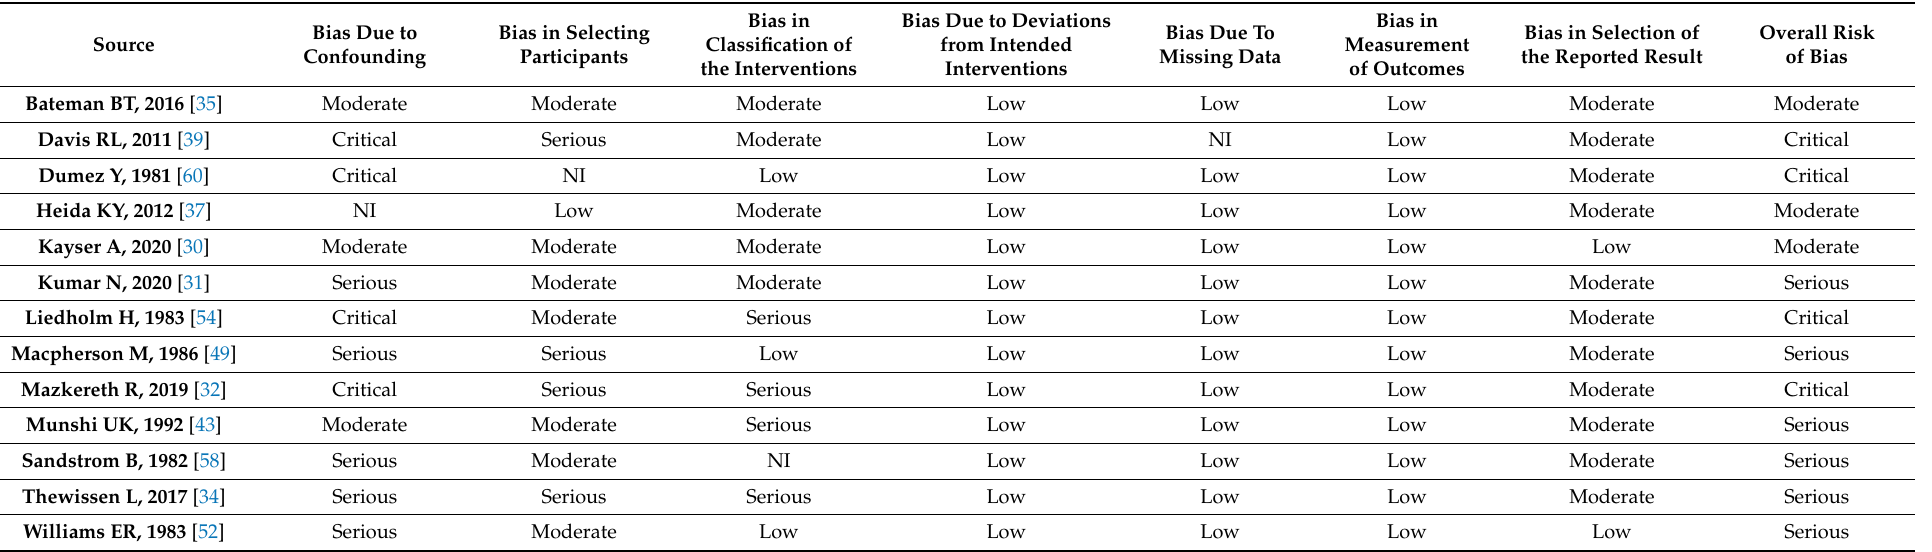
Table 5. Risk of bias in 13 non-randomized controlled